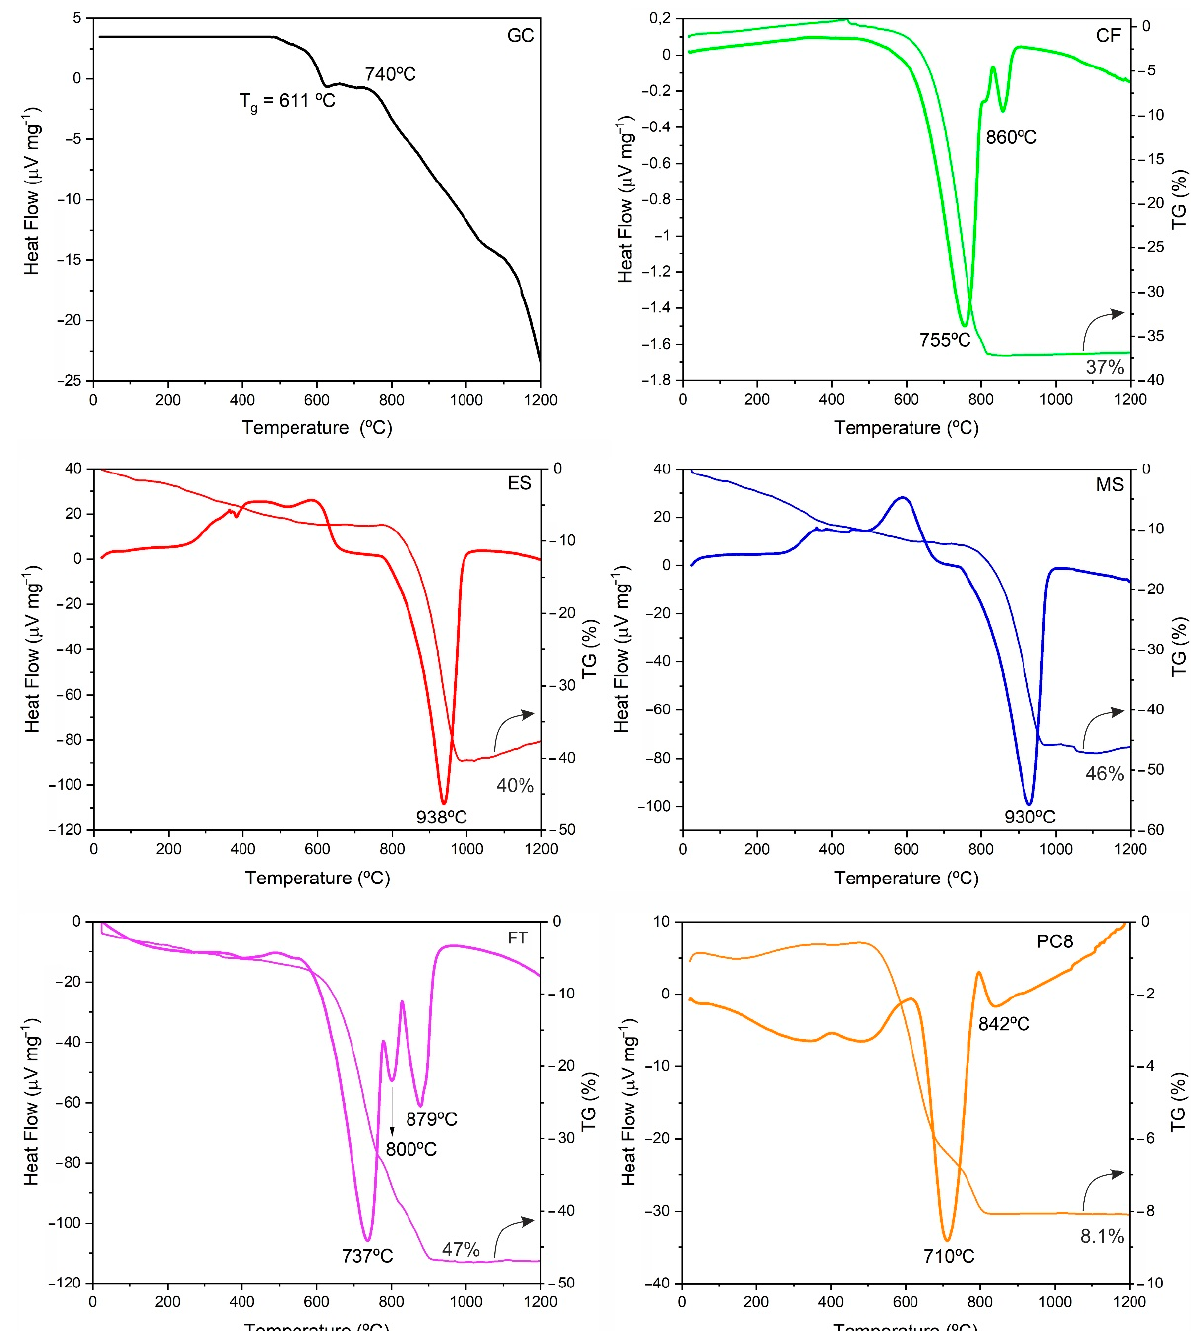
Figure 2. DTA/TG curves of raw materials: glass cullet (GC), eggshell (ES), mussel shell (MS), carbonate F (CF), flotation tailing (FT) and carbonate PC8 (PC8).